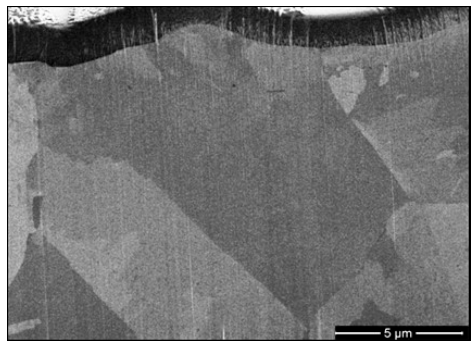
Figure 7. Cross section SEM image (12,000×).